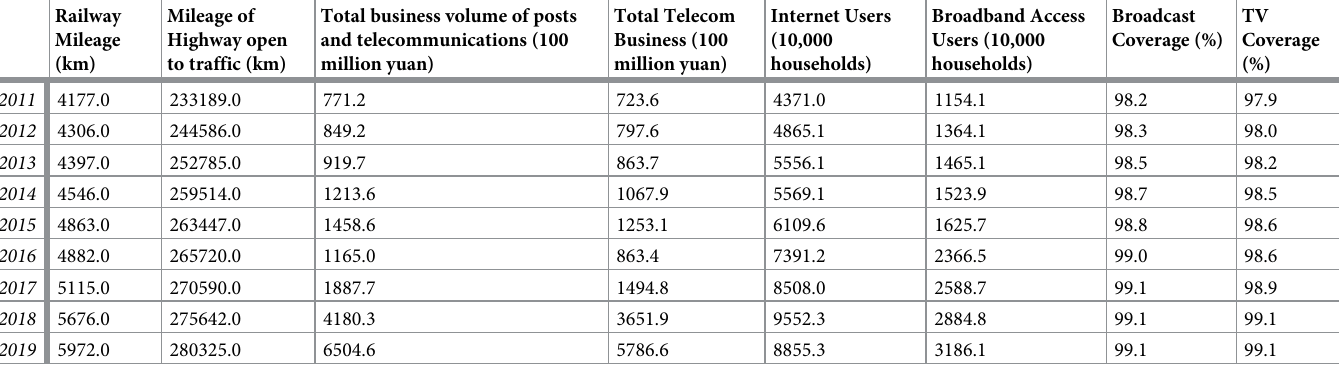
Table 1. Development status of agricultural informatization infrastructure in Shandong Province. Railway Mileage of Mileage Highway (km)